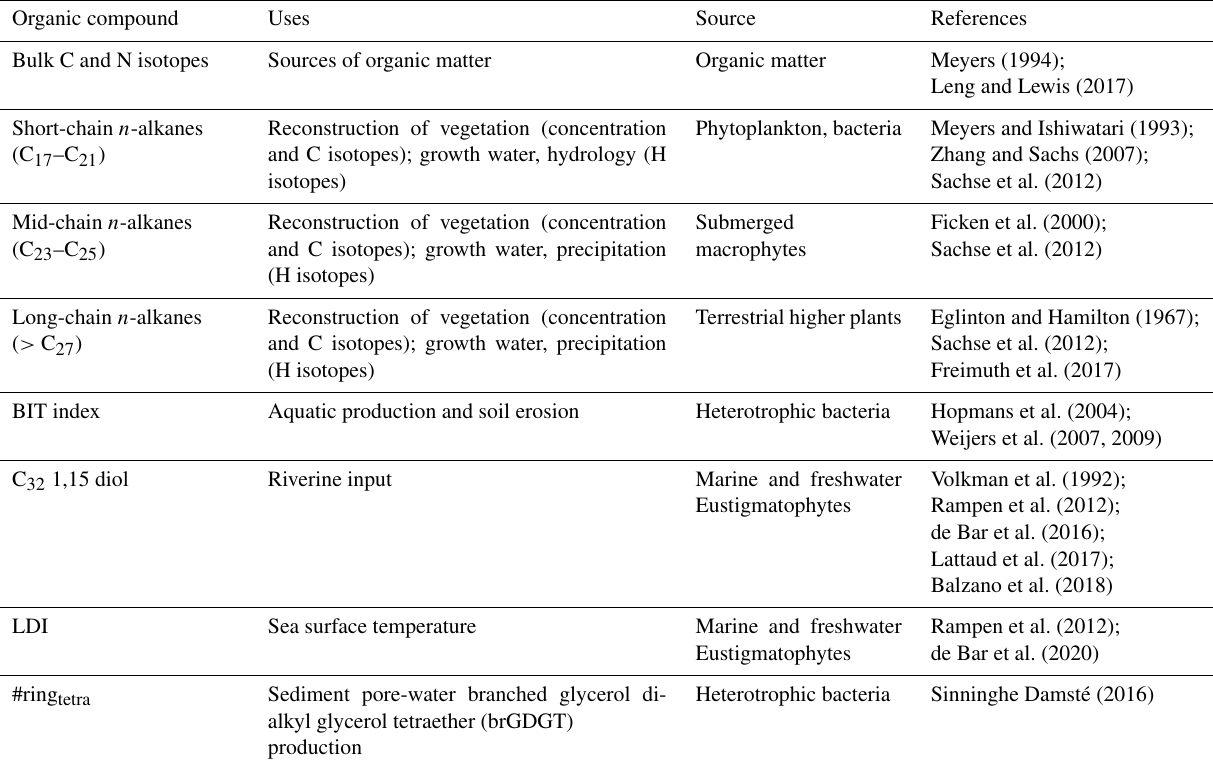
Table 1. Summary of the proxies applied in this study, how they are used as paleoclimate indicators, and their source(s). Organic